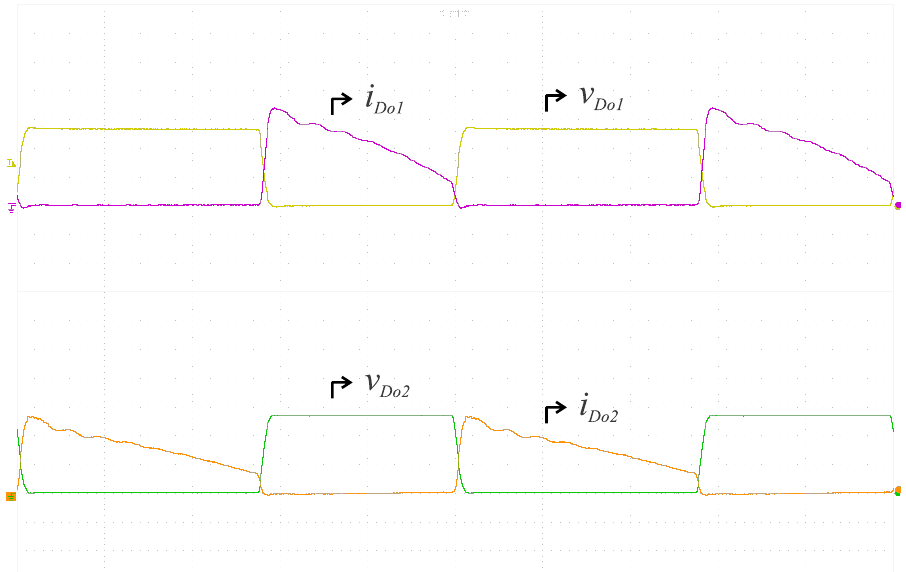
Figure 8. Top: diode D o 1 voltage v Do 1 (100 V/div) and current i Do 1 (500 mA/div); bottom: diode